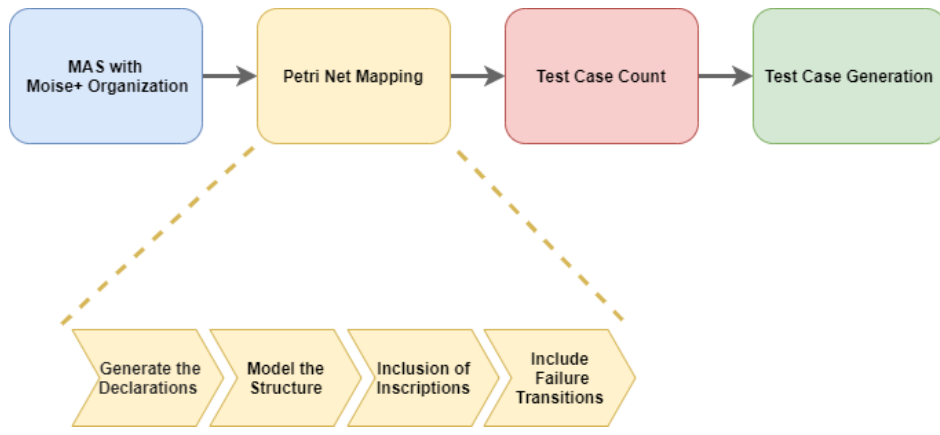
Figure 5. Sequence of steps for the proposed